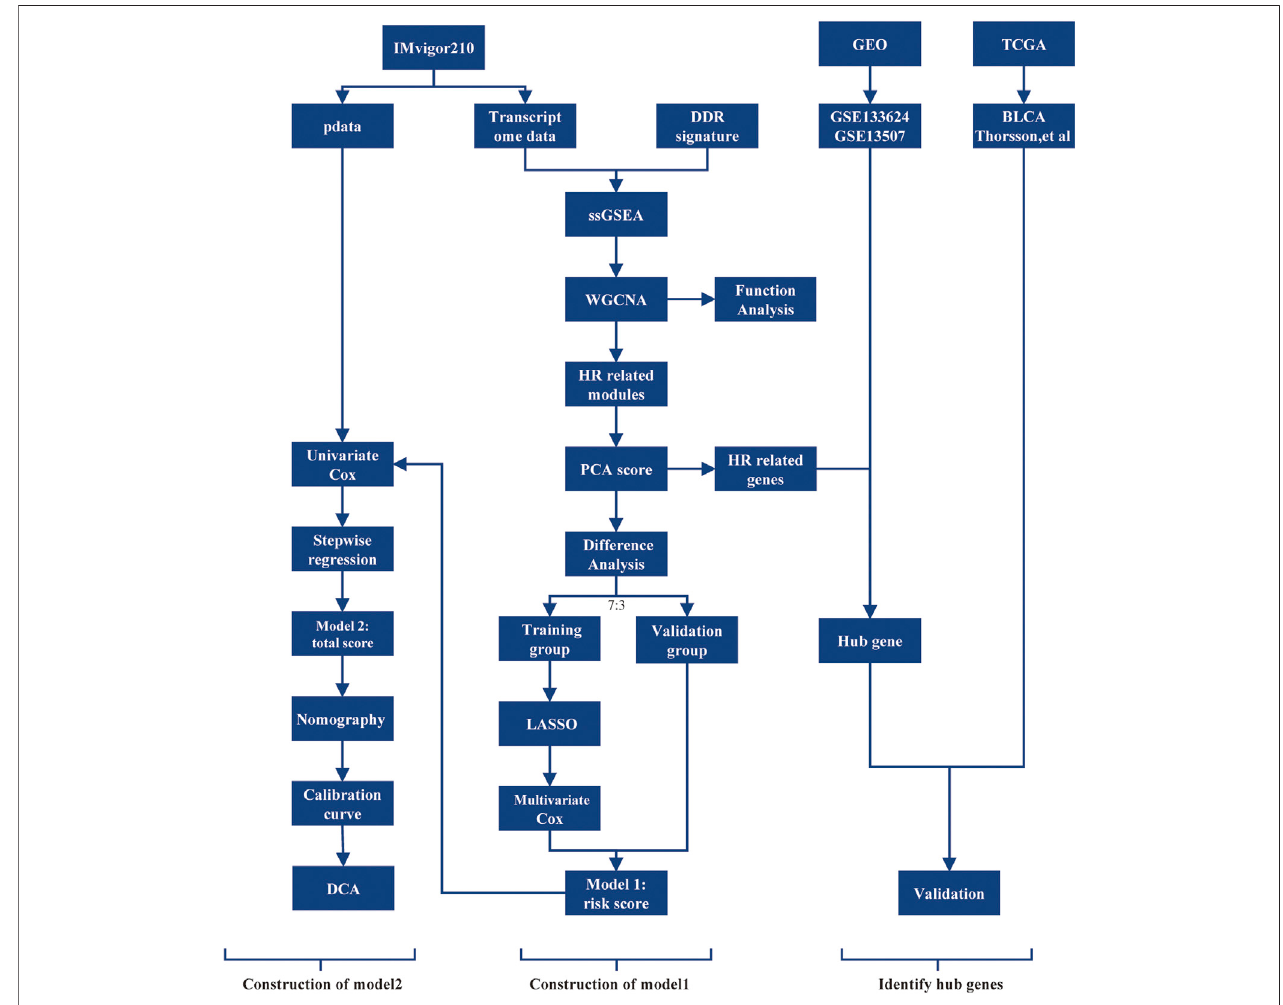
FIGURE 1 | The work fl ow of the selection process for the eligible studies in the analysis. DDR, DNA damage repair; ssGSEA, single sample gene set enrichment analysis; WGCNA, weighted gene co-expression network analysis; HR, homologous recombination; PCA, principal component analysis; LASSO, least absolute shrinkage, and selection operator; DCA, decision curve analysis; TCGA, The Cancer Genome Atlas; GEO, Gene Expression Omnibus.